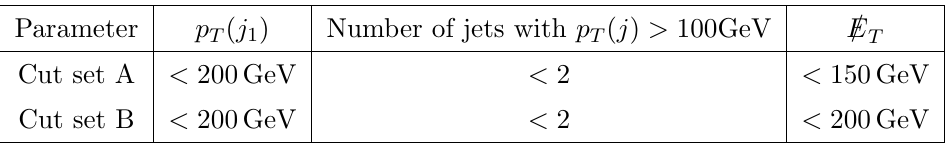
Table 1 . Selection cuts applied to suppress the squark-gluino processes. Here p T ( j 1 ) refers to the transverse momentum of the hardest